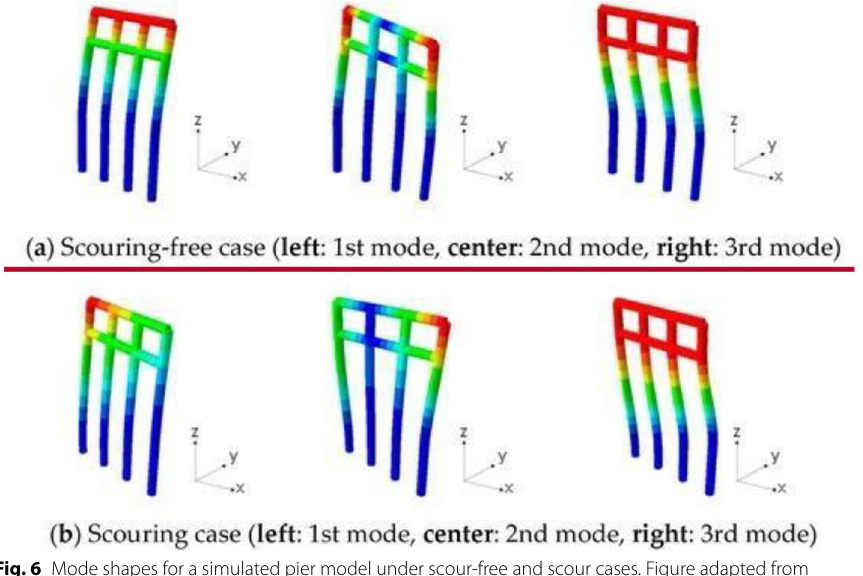
Fig. 6 Mode shapes for a simulated pier model under scour-free and scour cases. Figure adapted from Reference (Hashimoto et al. 2020) with permission from